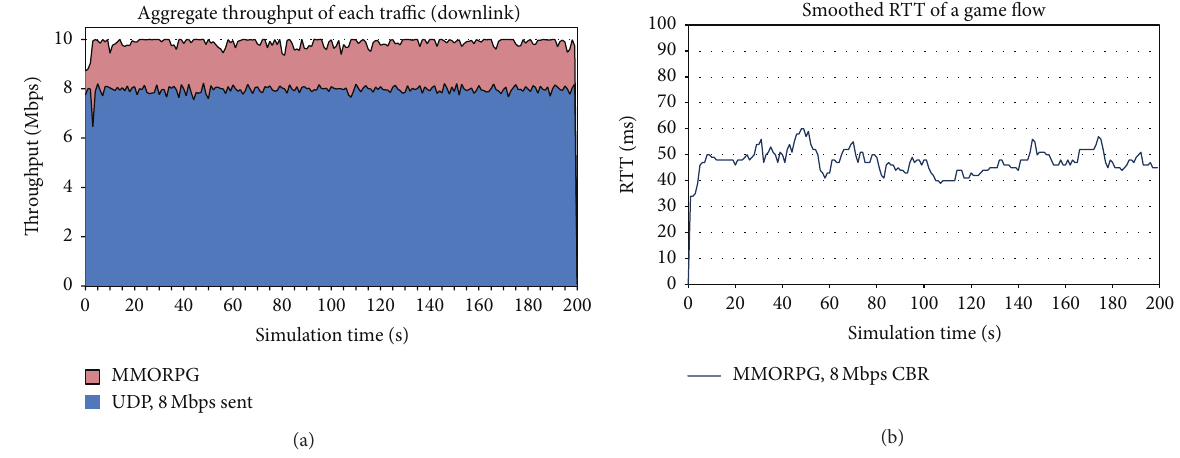
Figure 12: Coexistence of 100 MMORPG flows and 8 Mbps of UDP CBR traffic: (a) received throughput in the downlink by each traffic and (b) smoothed RTT of one of the game flows.